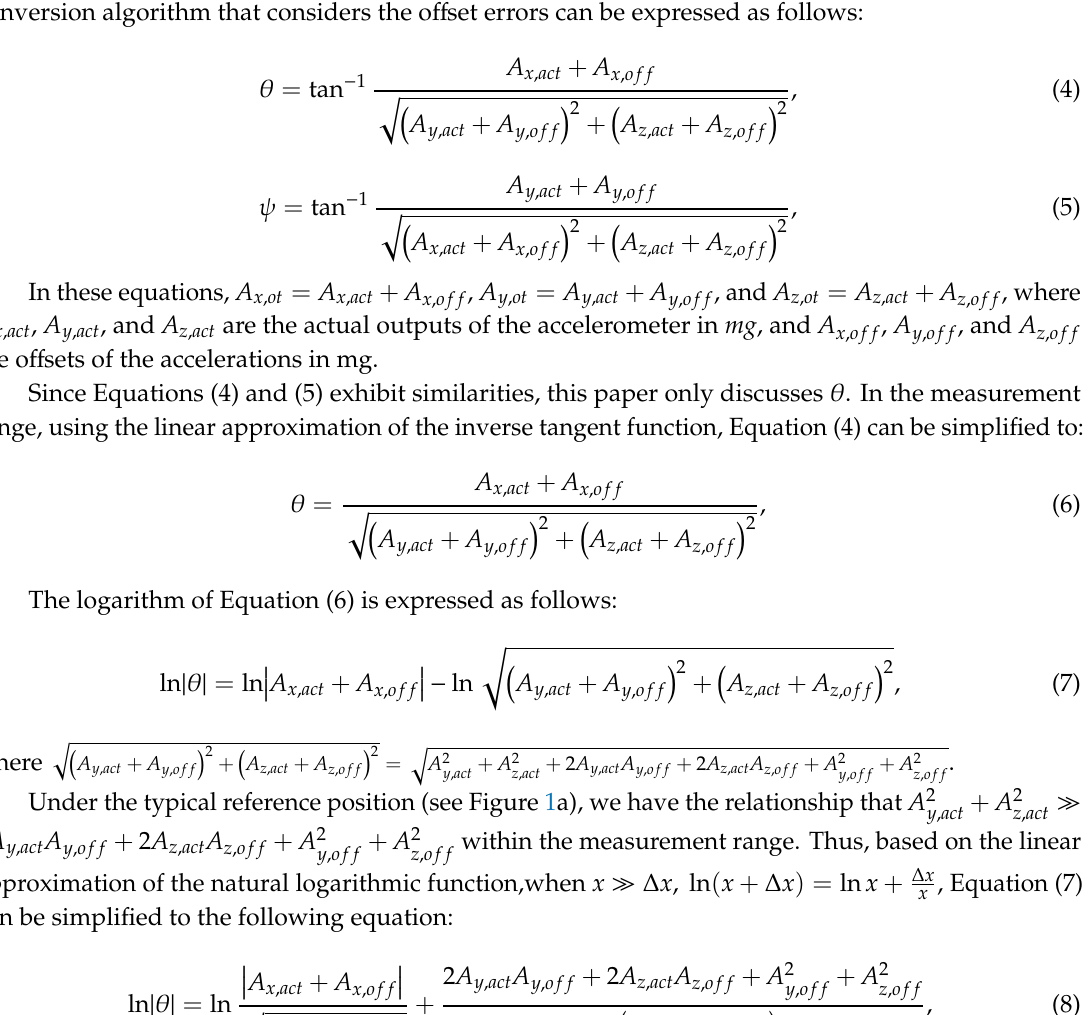
Figure 2. Sensing angles of the 1-axis and 2-axis MEMS accelerometer. ( a ) The 1-axis MEMS